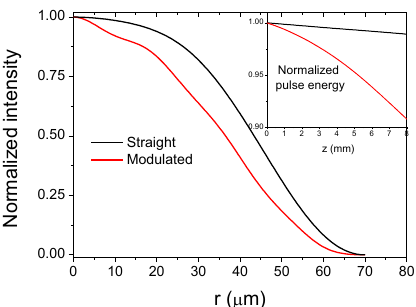
Fig. 5 Beam radial profile at HCW exit for the straight (black) and modulated (red) channel. The inset shows the evolution of the pulse eneergy along propagation direction.